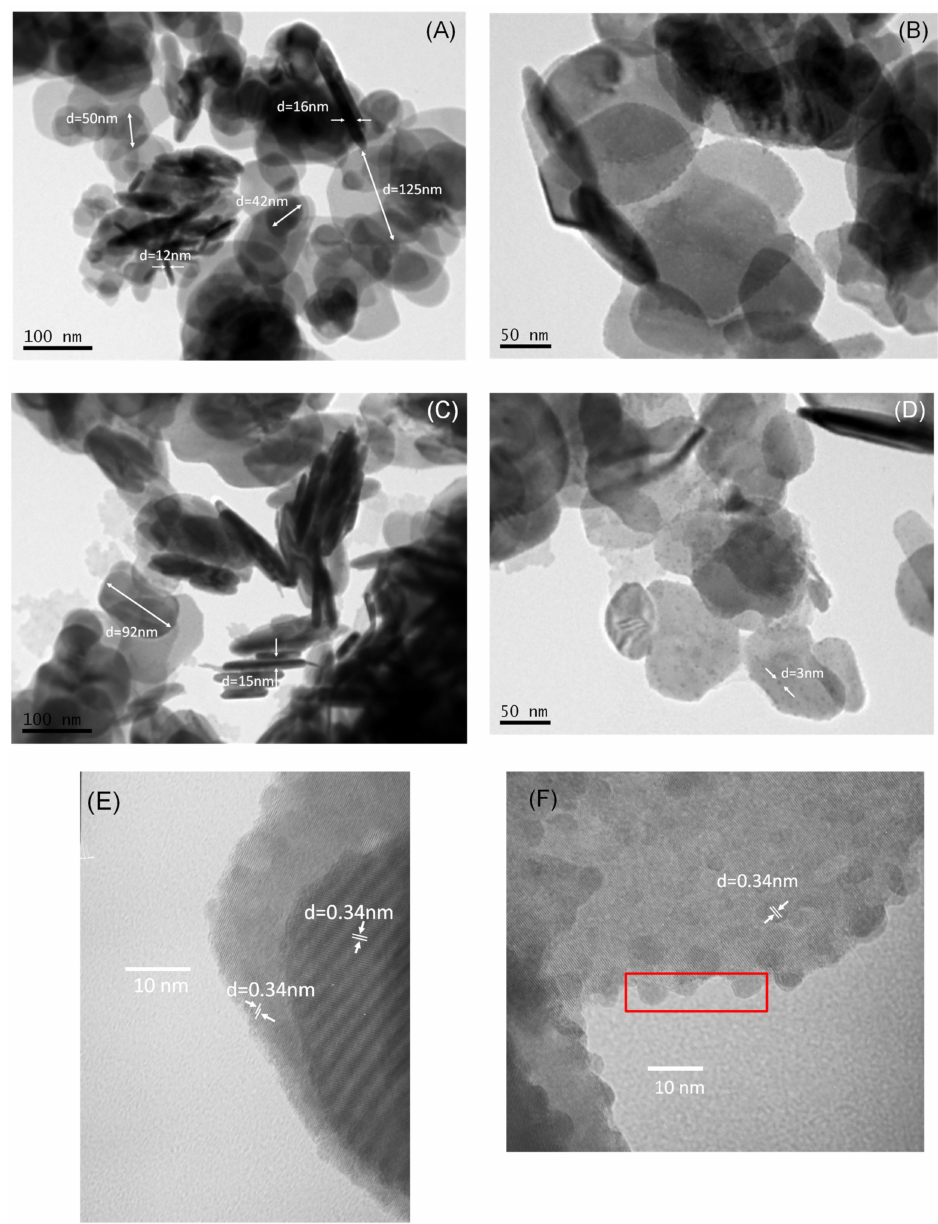
Figure 2. TEM images of ( A ), ( B ) BiOCl and ( C ), ( D ) 0.25 wt.% MoS 2 /BiOCl at different magnifications. HRTEM images of ( E ) BiOCl and ( F ) 0.25 wt.% MoS 2